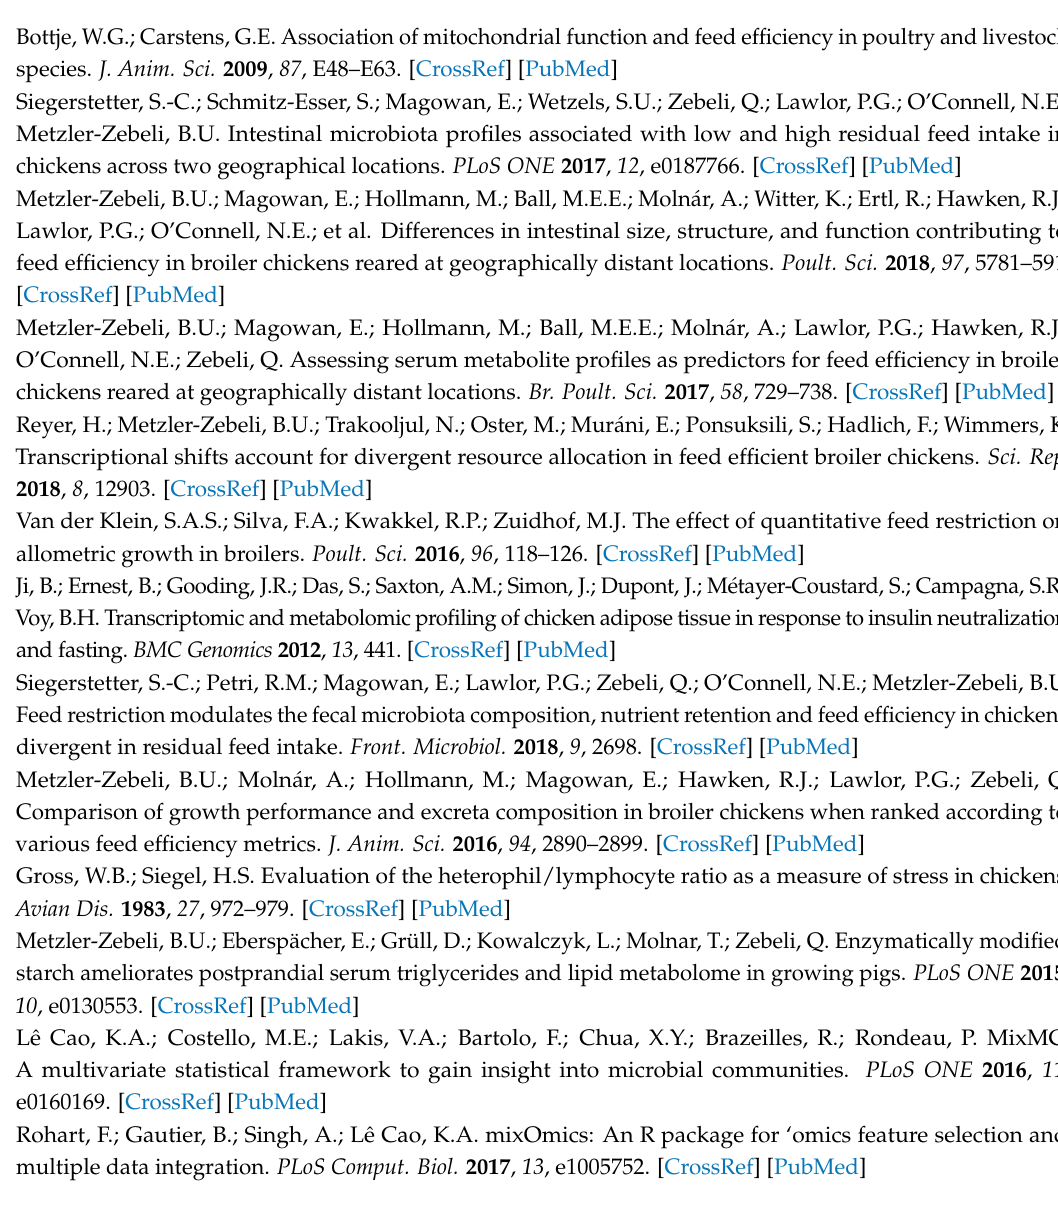
Table S1: Dietary ingredients and chemical composition of diets (on as-fed basis); Table S2: Total feed intake (TFI), total body weight gain (TBWG), and residual feed intake (RFI) values of low and high RFI broiler chickens fed either ad libitum or restrictively; Table S3: Additional serum metabolites ( µ mol/L) in low and high RFI broiler chickens fed either ad libitum or